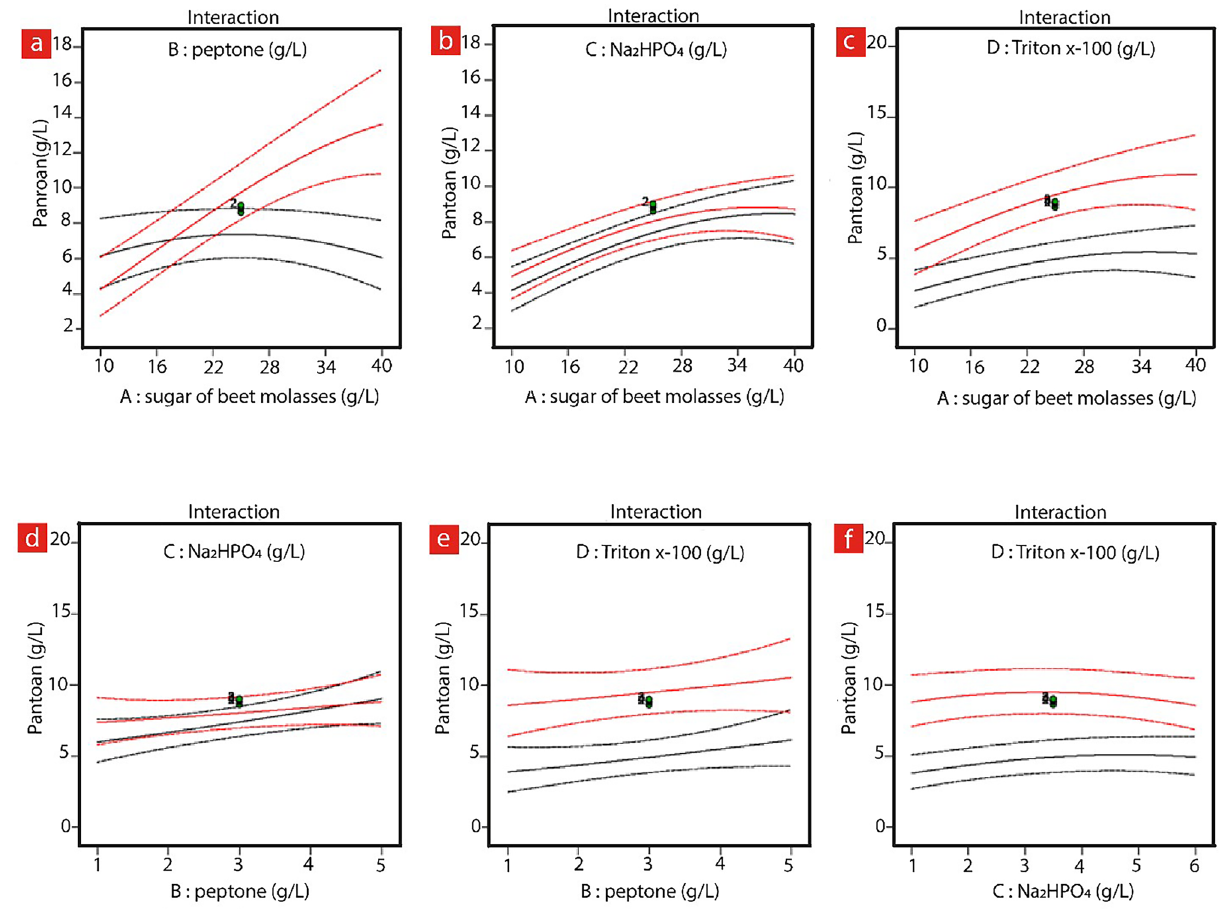
Figure 4. The interaction effects between all factors on Pantoan production using Design Expert software (Version 10.0.7.0, Stat-Ease Inc., Minneapolis, USA). ( a ) Interaction between the peptone and SBM. ( b ) interaction between the Na 2 HPO 4 and the SBM, ( c ) interaction between the Triton X-100 and SBM, ( d ) interaction between the peptone and the Na 2 HPO 4 . ( e ) Interaction between the peptone and the Triton X-100, and ( f ) interaction between the Na 2 HPO 4 and the Triton X-100.In order to acquire the maximum Pantoan concentration and therefore the optimum levels of SBM, peptone, disodium hydrogen phosphate, and Triton X-100, a second-order polynomial model was employed to determine the values of these variables. According to the predicted conditions given by the model, the maximum Pantoan yield (10.30 g/L) is obtained at the concentrations of 31.5, 2.73, 2.99, and 0.32 g/L for SBM, peptone, disodium hydrogen phosphate, and Triton X-100, respectively. These numbers illustrate the optimal condition for Pantoan production from molasses